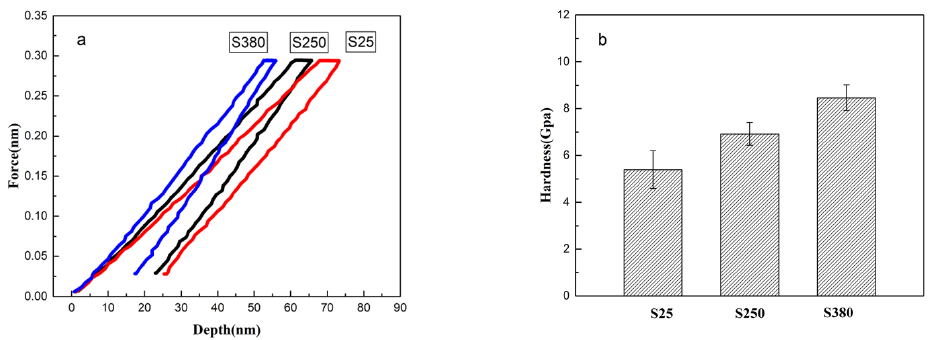
Figure 8. Force-depth curves ( a ) and hardness ( b ) of S25, S250, and S380 by nanoindentation with a loading rate of 0.2 mN/s.